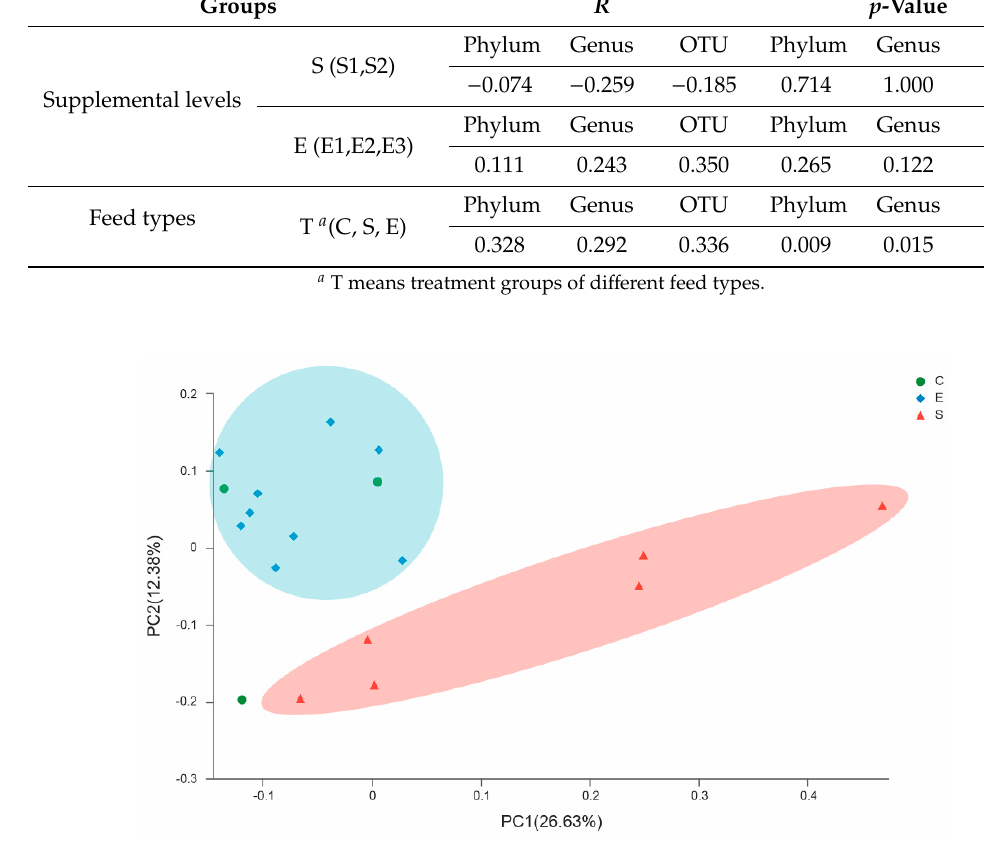
Table 1. Analysis of similarities (ANOSIM) for rumen microbial composition at the phylum, genus and operational taxonomic unit (out) level.